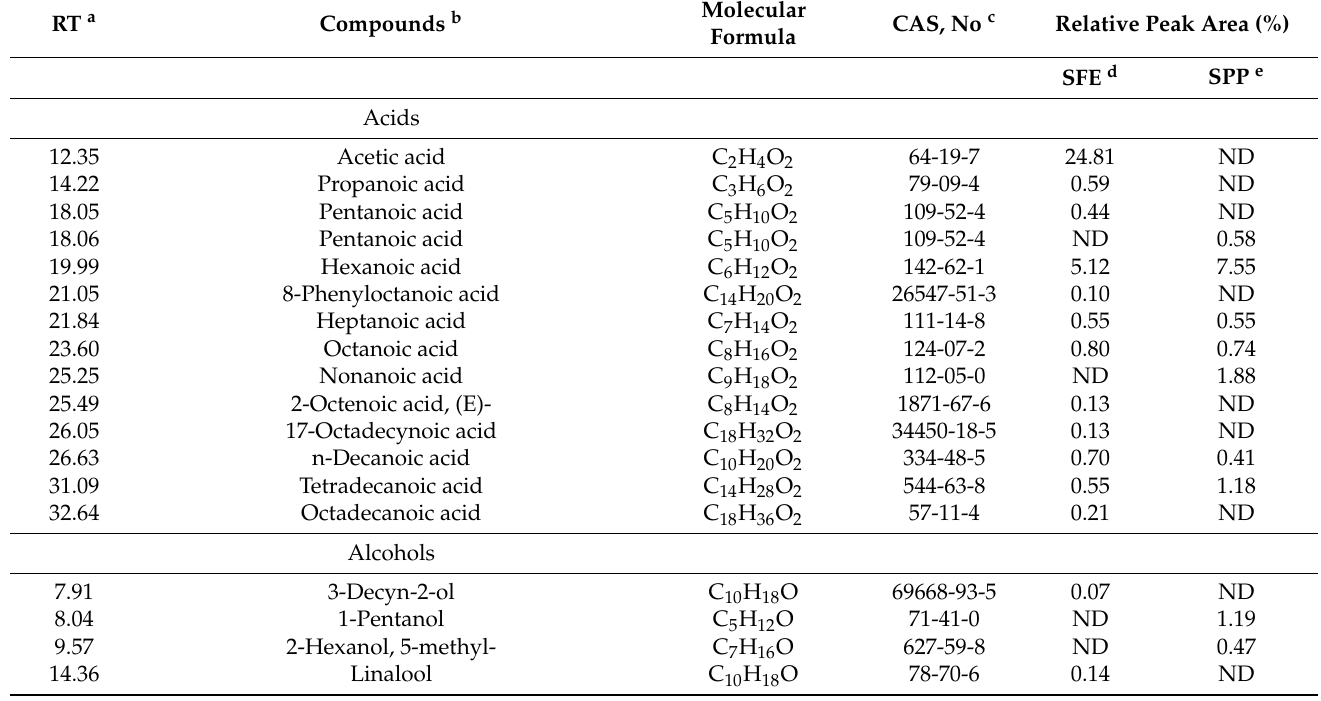
Table 1. Relative content of volatile compounds identified in gurum seeds oil obtained by SFE and SPP using